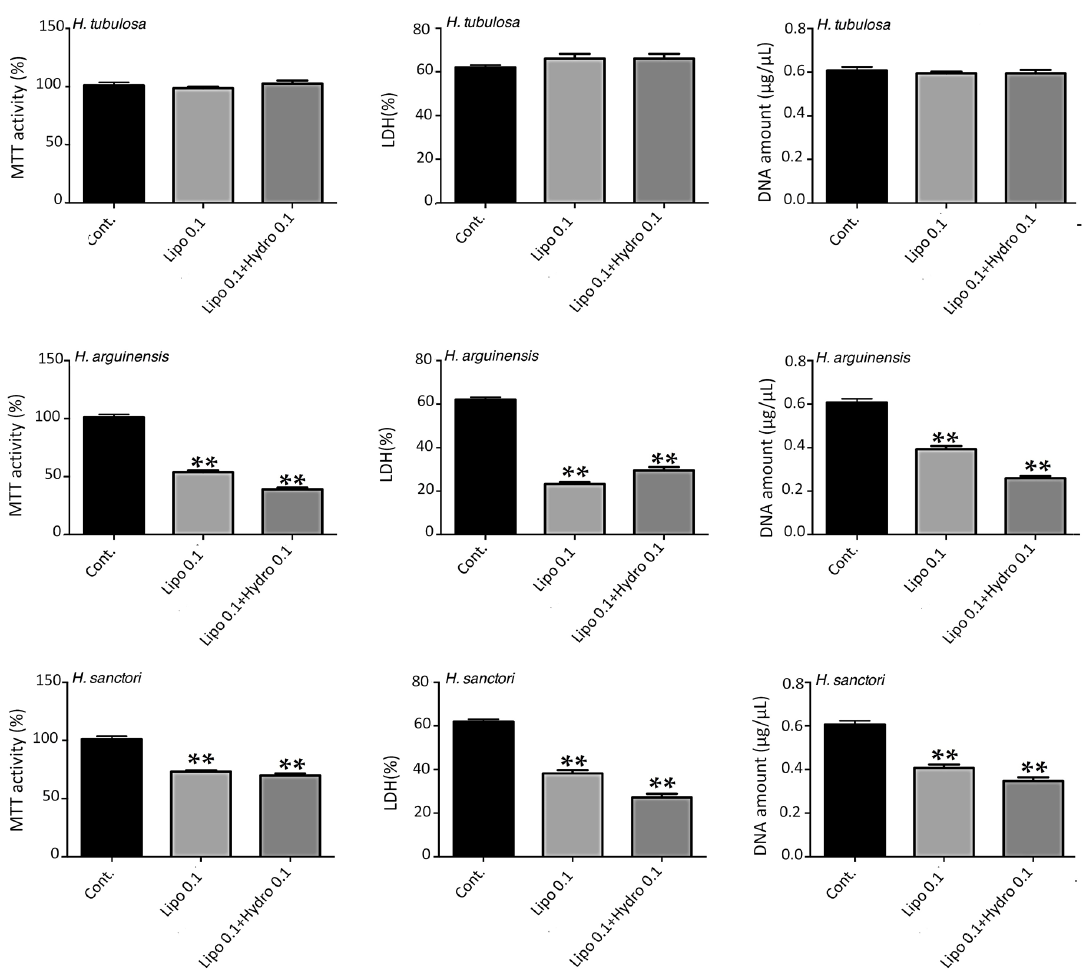
Figure 3. Impact of nanoliposomes without hydrolysates (Lipo 0.1) and with hydrolysates (Lipo 0.1+ Hydro 0.1) on human MSC. Human MSCs were exposed to nanoliposomes alone (0.1 mg/mL) or